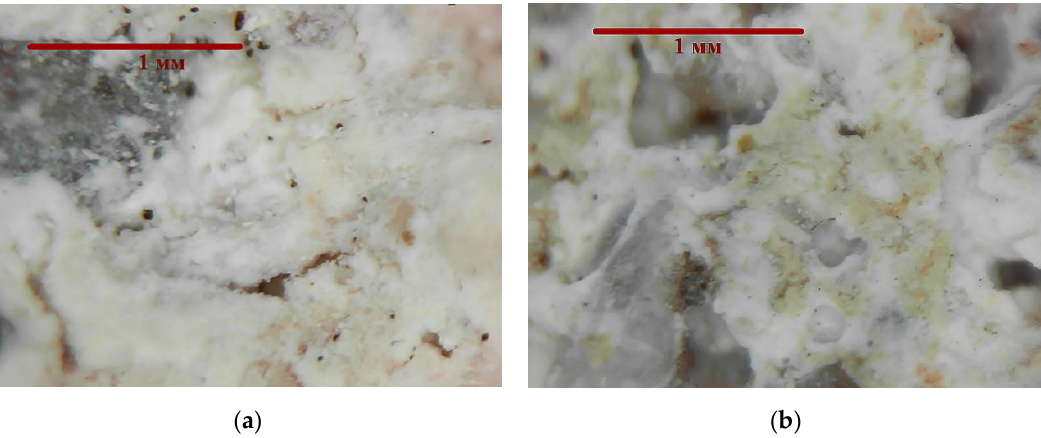
Figure 9. Ancient lime mortars under an optical microscope: ( a ) cryptocrystalline structure of secondary calcite ( b ) calcite between quartz grains.